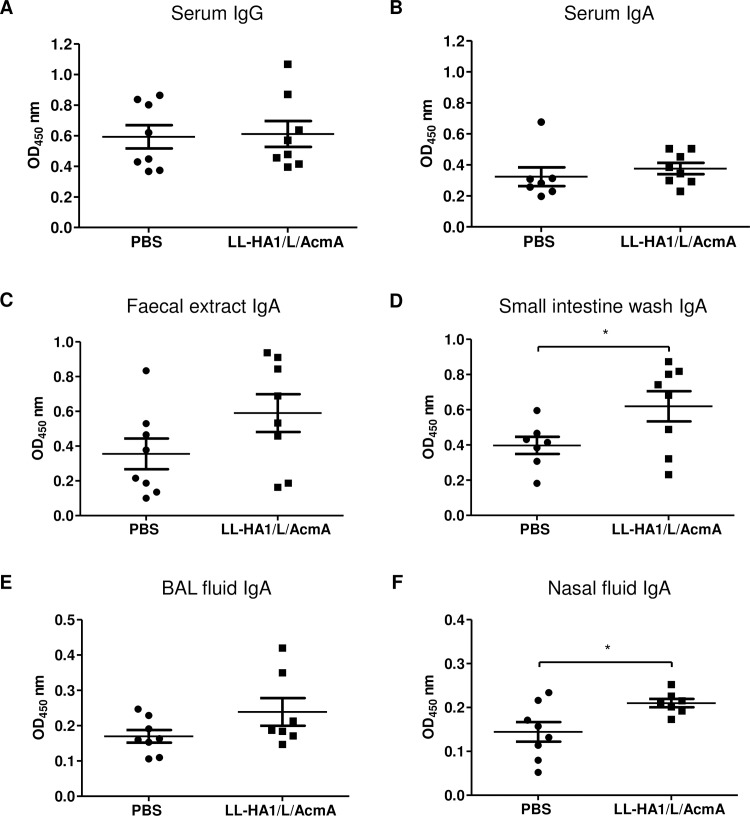
HA1/L/AcmA-specific IgG and IgA detected by ELISA.Mice (8 mice/group) were orally immunized with PBS or LL-HA1/L/AcmA, and samples were collected 2 weeks after the last immunization. HA1/L/AcmA-specific (A) IgG and (B) IgA in serum at 1:10 dilution were determined, in addition to HA1/L/AcmA-specific IgA in (C) faecal sample (1:5 dilution), (D) small intestine wash (neat), (E) BAL fluid (neat) and (F) nasal fluid (neat). One significant outlier was removed from the data set for serum IgA and small intestine wash of PBS-treated group, as well as BAL and nasal fluid of LL-HA1/L/AcmA-treated group (Grubbs’ test, p<0.05), respectively. Data are presented as mean ± standard error of the mean. Asterisks indicate statistically significant differences between the corresponding groups (*p<0.05).